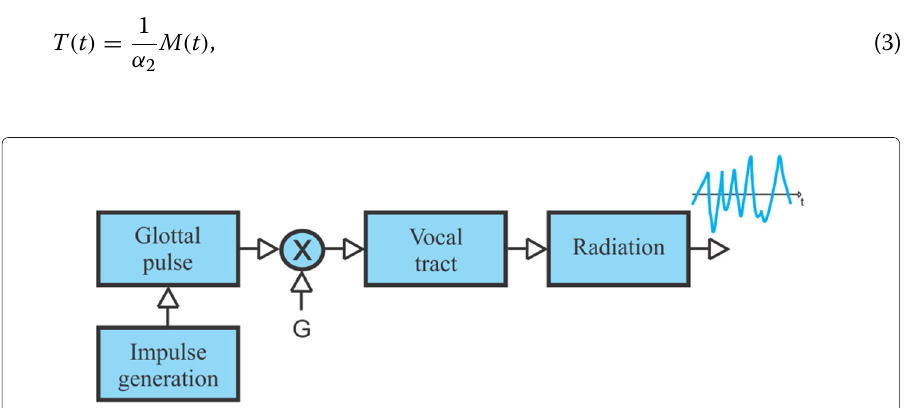
Fig. 1 Block diagram of the new voice generation